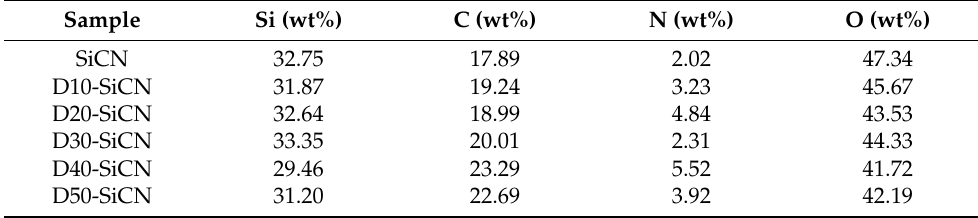
Figure 3. ( a ) Optical image showing SiCN thin film sensor. ( b ) SEM image showing a single DIW- SiCN line (inset shows EDS analysis conducted in the line scan mode). ( c ) Surface morphology of the DVB20-SiCN film. ( d ) SEM image showing the cross section of the DVB20-SiCN film (inset shows EDS analysis conducted in the line scan mode). Table 1. Results of elemental